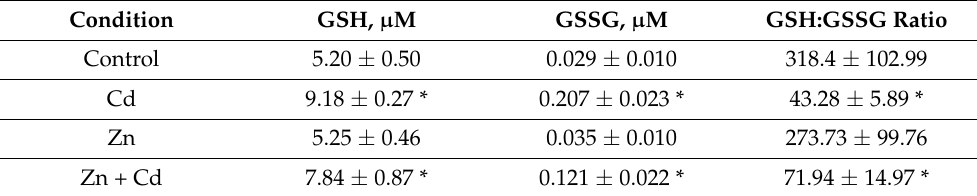
Table 2. Effects of Zinc supplementation on glutathione (GSH) and glutathione sulfide (GSSG) concentrations and GSH:GSSG ratio in choroid plexus epithelial cells (CPECs) exposed to 500 nM CdCl 2 for 12